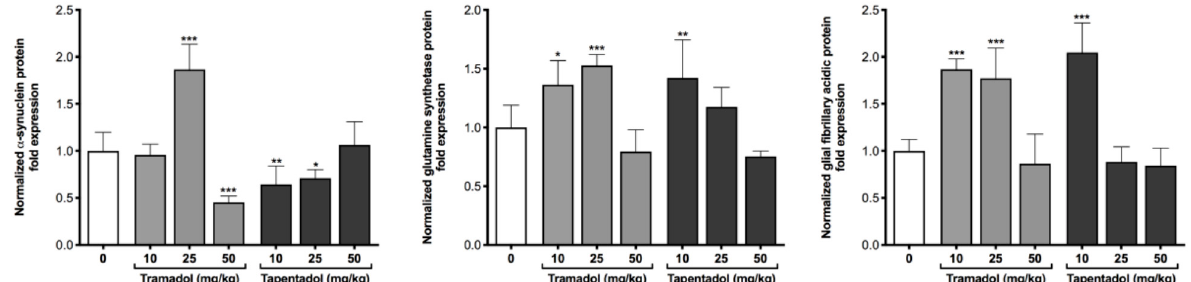
Figure 4. Normalized protein expression levels of neuronal marker α -synuclein and astrocytic markers glutamine synthetase (GS) and glial fibrillary acidic protein (GFAP), in protein extracts from brain cortex tissue, upon Wistar rat repeated daily intraperitoneal (i.p.) administration of 10, 25 or 50 mg/kg tramadol or tapentadol, for 14 consecutive days. Expression levels were normalized against total protein content, using α -tubulin as loading control, and then against the respective controls (administered with normal saline), set as 1. Results are expressed as means ± SD. *** p < 0.001, ** p < 0.01, * p < 0.05.